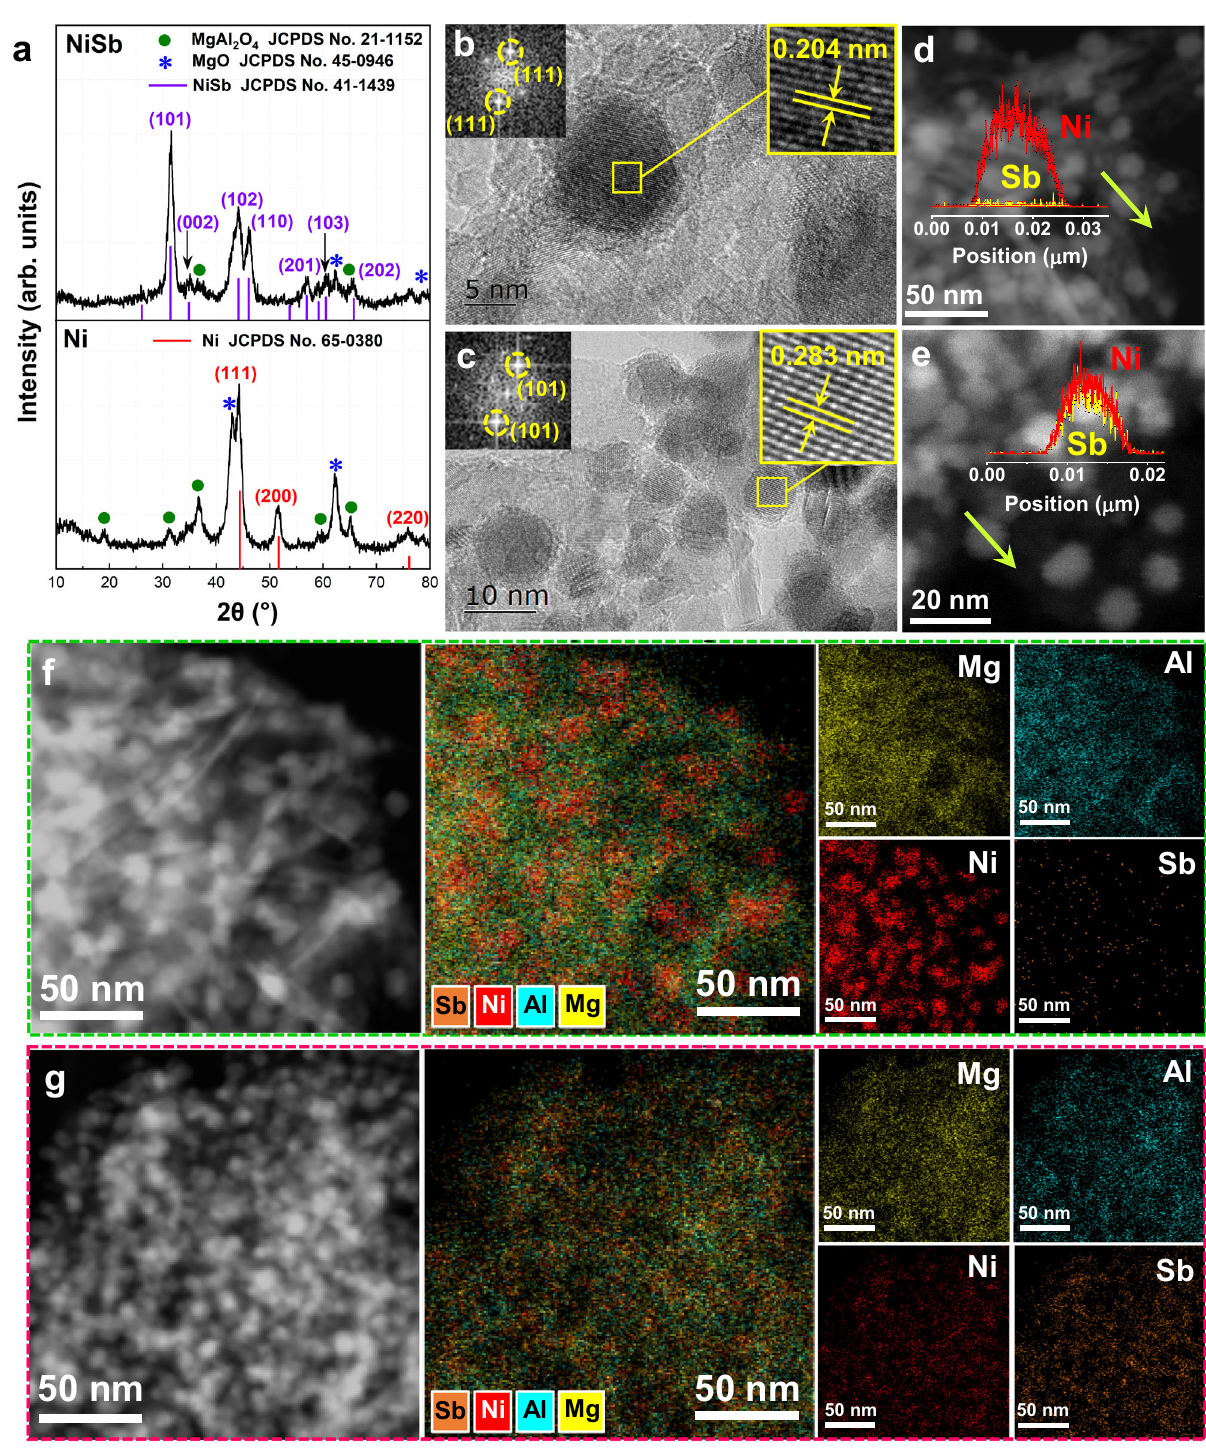
Fig. 3 | Microstructure and morphology of NiSb intermetallic catalyst. a XRD patterns of the synthesized Ni and NiSb catalysts. Typical HRTEM images and corresponding FFT patterns of b Ni and c NiSb catalysts. HAADF-STEM images